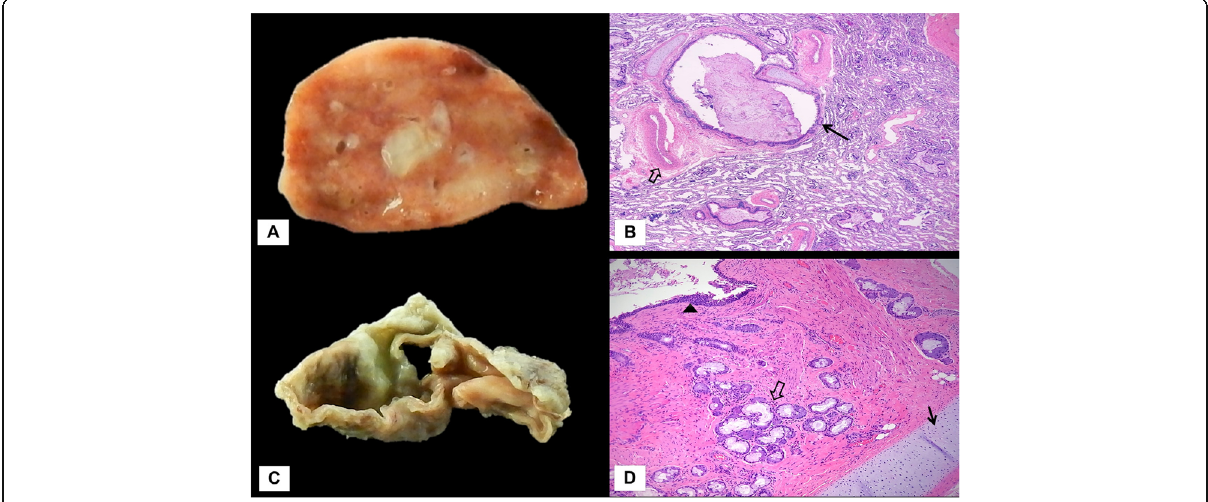
Fig. 5 Gross image demonstrating a cross-section of the extralobar pulmonary sequestration, demonstrating focal cystic lung parenchyma ( a ). Microscopic image demonstrating cystic lung parenchyma with extravasated mucin (arrow) and thick-walled vessels (open arrow), × 20 magnification ( b ). Gross image demonstrating a cross-section through the bronchogenic cyst ( c ). Microscopic image demonstrating cyst wall (arrowhead) with bronchial glands (open arrow) and cartilage (arrow), compatible with bronchogenic cyst, × 40 magnification ( d